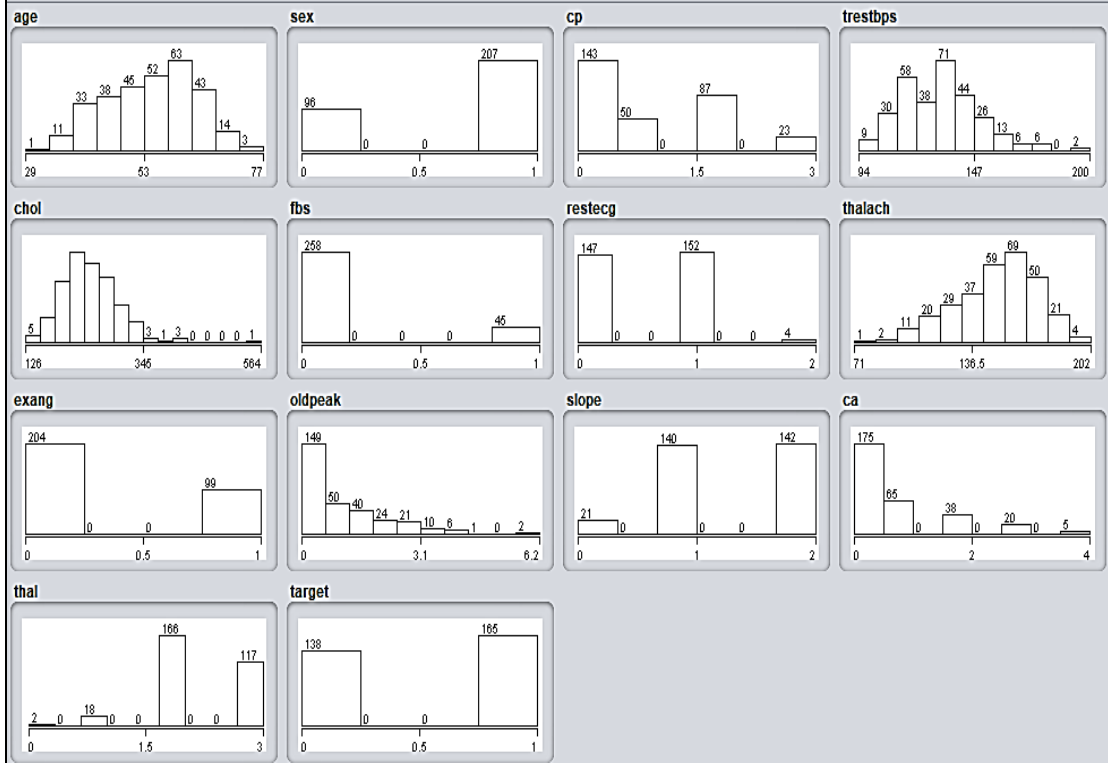
Figure 3. The visualization feature set of the cardiovascular disease dataset. Table 3. The statistical value of the feature sets and their information.